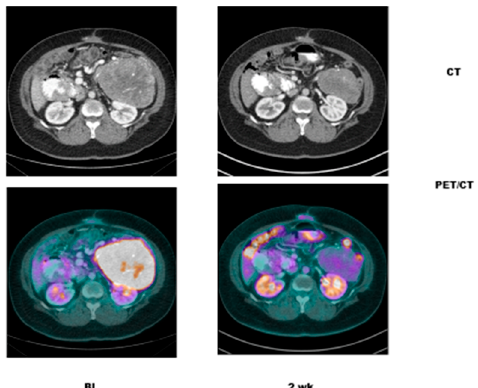
Figure 4. PRE and POST CT and PET/CT in a female in her 40’s with recurrent GIST. She has had multiple prior therapies and had relapsed from several TKI’s. After 2 weeks of novel therapy, she has had a complete metabolic response, but only a partial anatomic response.